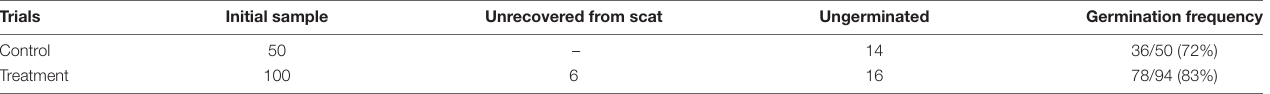
TABLE 1 | Seed counts of P . microphylla in trial conditions of the primary study involving the Western Diamond-backed Rattlesnakes ( C. atrox ). Trials